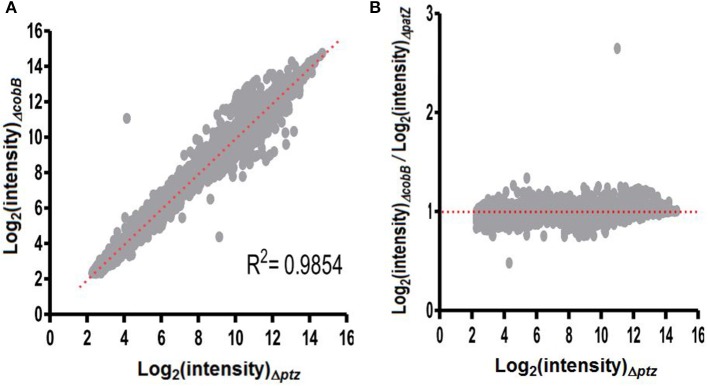
Relationship between the profiles of expression corresponding to both E. coli mutant strains when cultured in chemostat. (A) Linear relation between the expression levels of each gene belonging to the strain, whether it belongs to the ΔpatZ (deficit in acetyl-transferase) or to the ΔcobB (deficit in deacetylase). (B) A ratio in function of the log2 (intensity)ΔpatZ where the ratio is given by quotient between the log2 of the transcript intensities of ΔcobB and ΔpatZ.